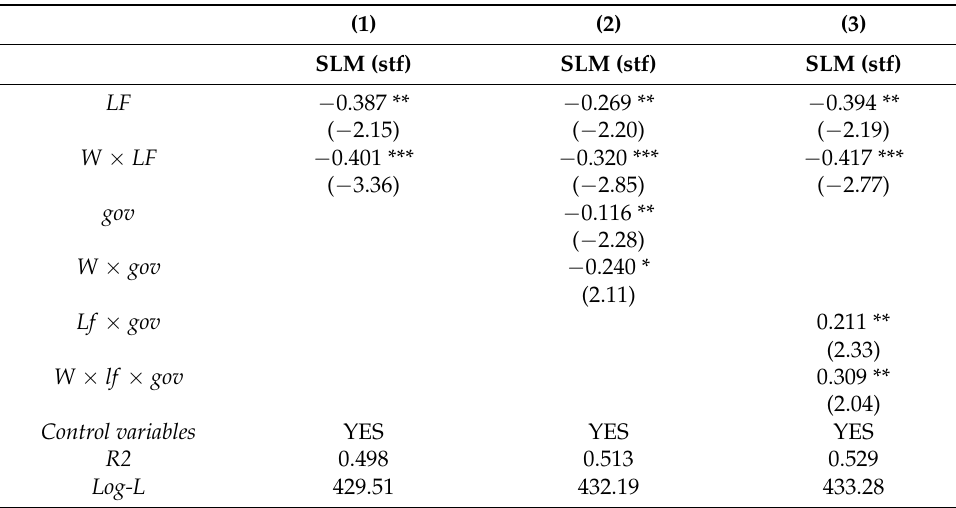
Table 7. The regulating effect of local government competition.